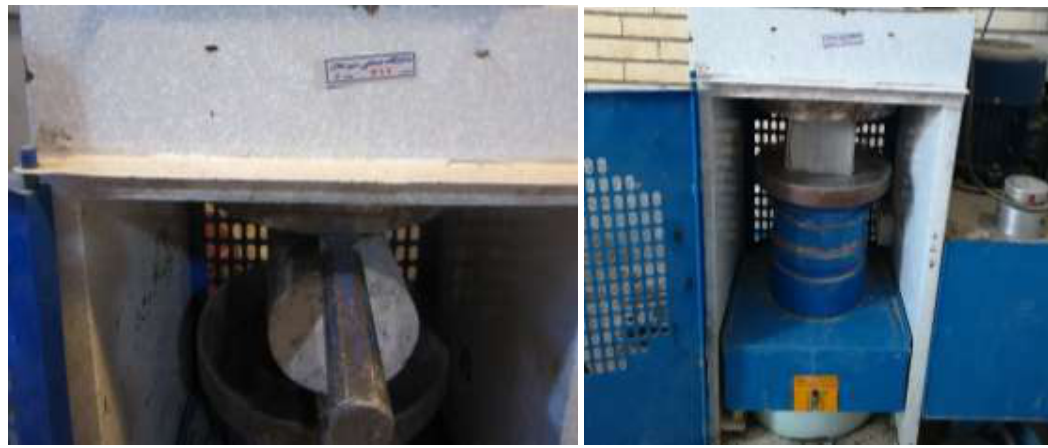
Figure 3. The compressive and splitting tensile strength of samples Water penetration depth determination test was carried out according to EN 12390-8. To do this, for each mixing design, three 10 × 10 cubes were made immediately after the surface molding of the sample, exposed to water pressure, with a rough wire brush and at 28 days for 72 hours under pressure 500kPa. Then the sample was removed from the machine and after drying perpendicularly to the surface exposed to water pressure, Doubling and the depth of water penetration was